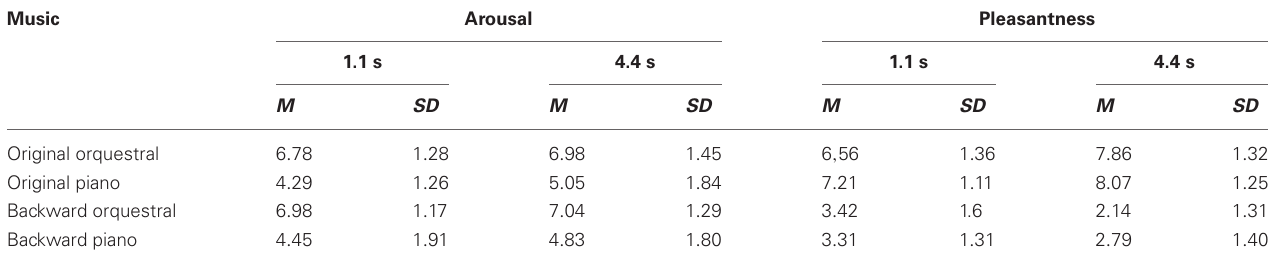
Table 3 | Mean ratings and standard deviation of arousal and pleasantness (9-point scale) of musical excerpts in original × backward and orchestral × piano conditions for a 1.1 and a 4.4-s